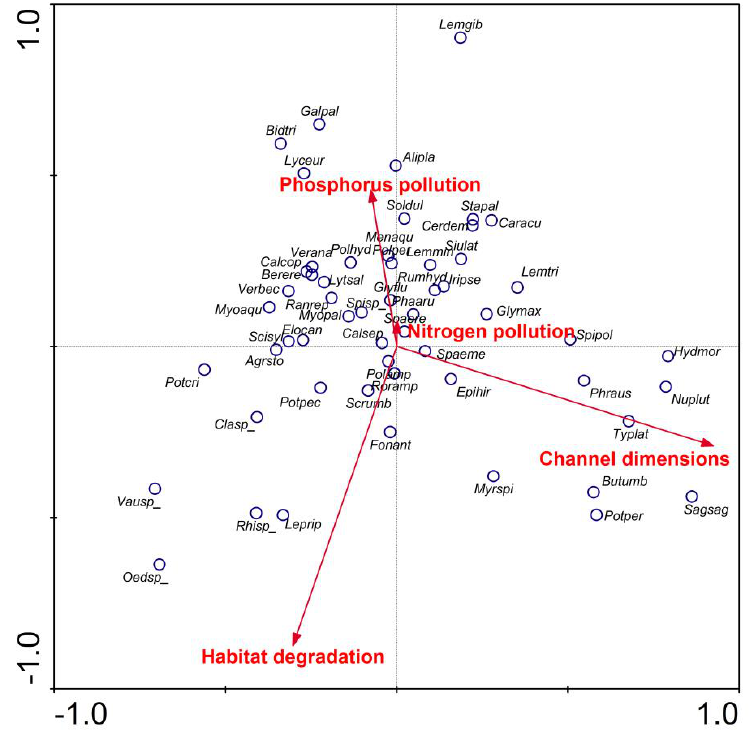
Figure 2. CCA of 56 most frequent species (frequency ≥ 10%) and environmental variables (PCA factors). A description of the abbreviations is provided in the Supplementary Materials (Table